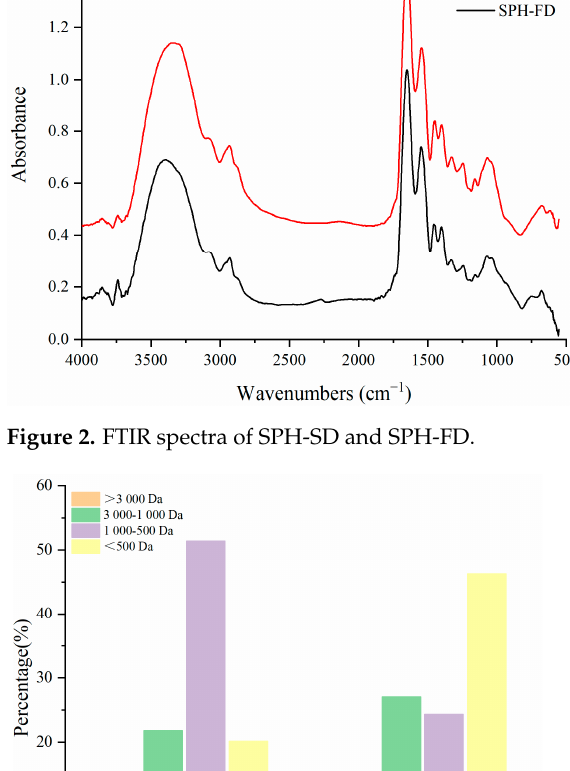
Figure 2. FTIR spectra of SPH-SD and SPH-FD.